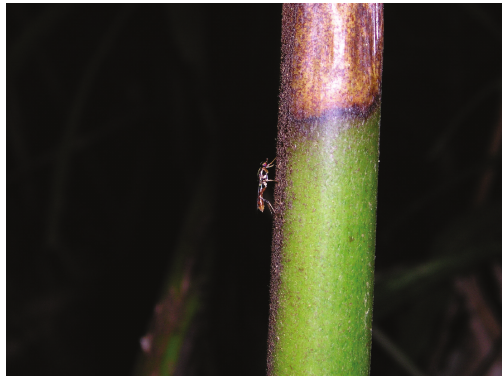
Figure 6: Male of Merosargus cf. varicrus on the Heliconia episcopalis pseudostem with rotten